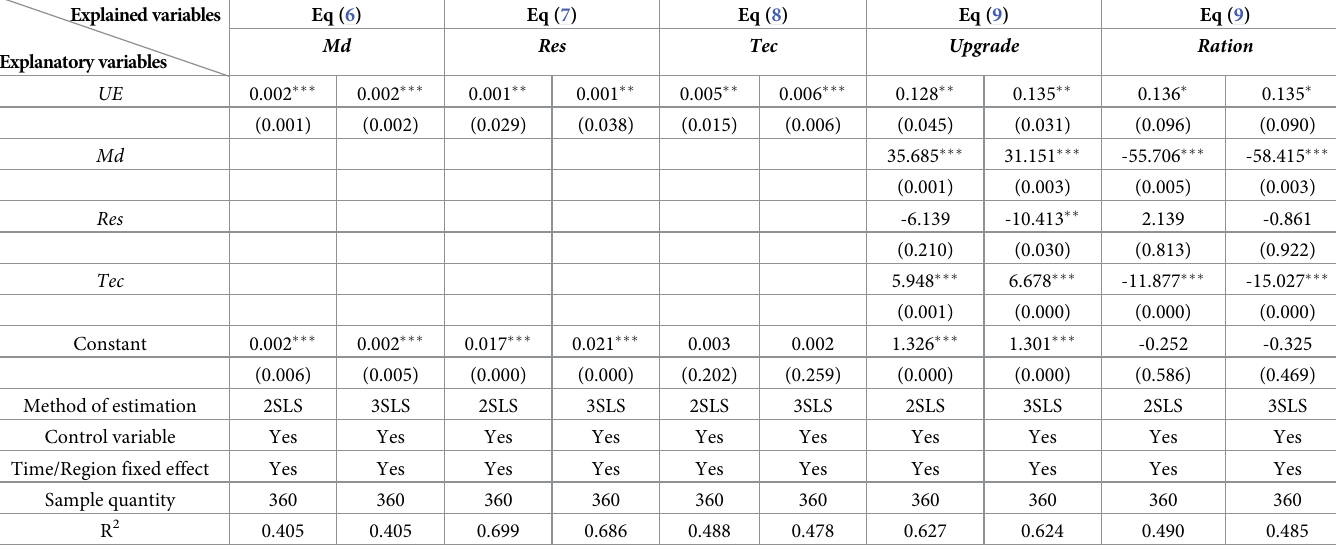
Note: The values in brackets are P values � , �� and ��� respectively represent a significance level of 10%, 5%and 1%.